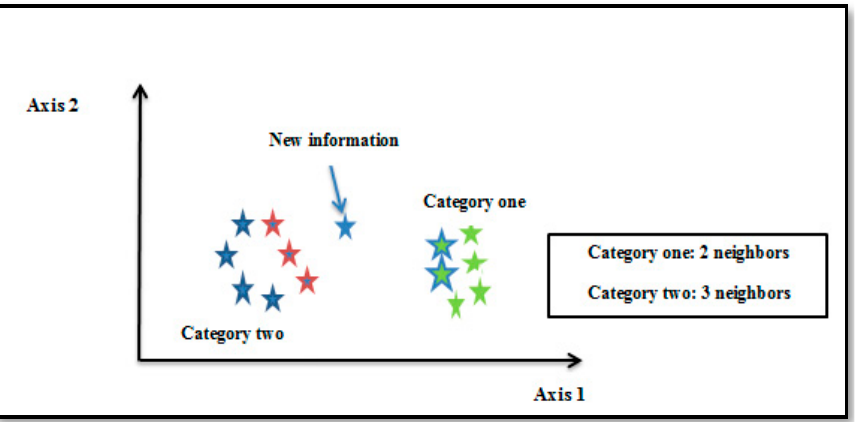
Figure 10. K-Nearest Neighbor example. Figure 10. K ‐ Nearest Neighbor example.